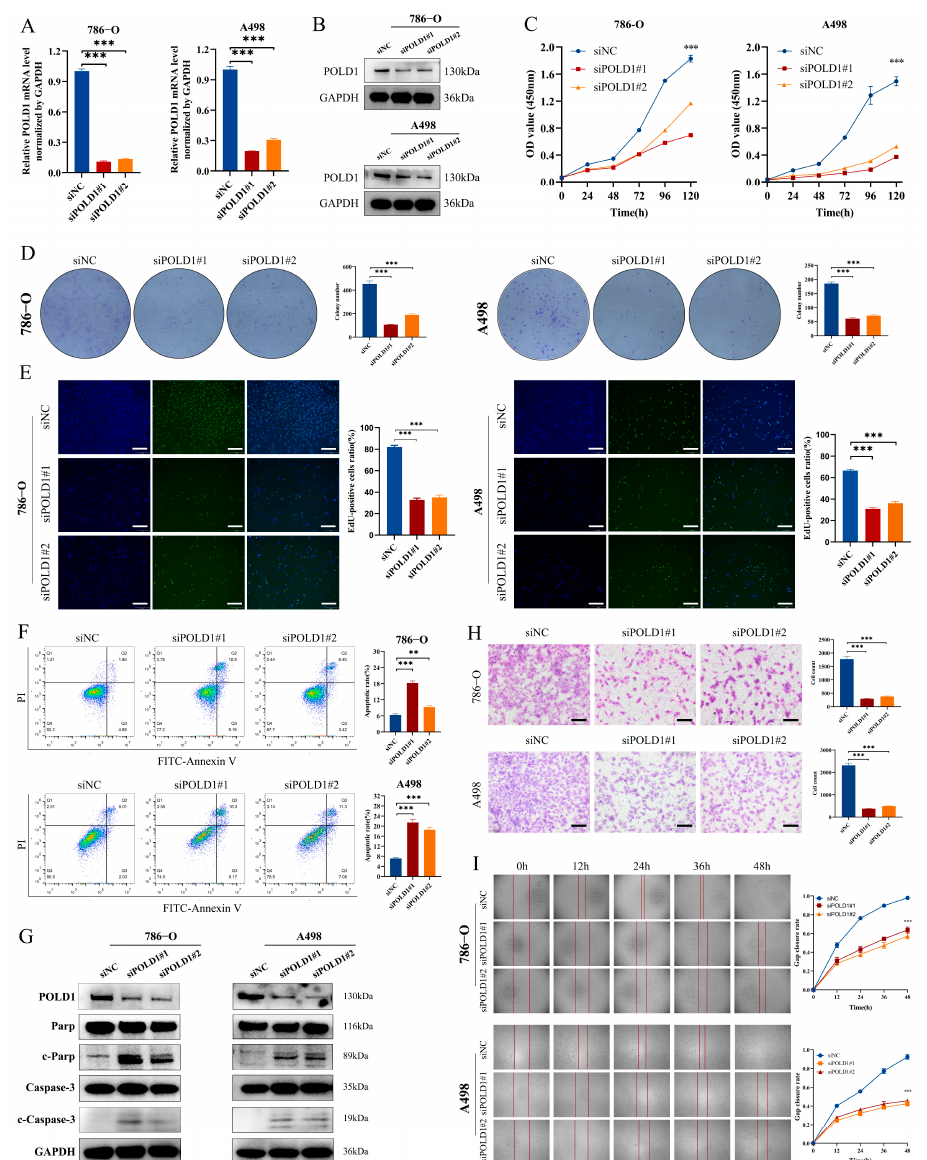
Figure 8. Knockdown of POLD1 inhibited the malignant biological behaviors of ccRCC cells in vitro. ( A , B ) The level of POLD1 was evaluated by RT-qPCR ( A ) and Western blot ( B ) after the knockdown of POLD1 in ccRCC cells. ( C – E ) The proliferation of ccRCC cells was detected by CCK-8 ( C ), colony- formation ( D ), and EdU assays ( E ). ( F , G ) Inhibition of POLD1 resulted in increased apoptosis in ccRCC cells via flow cytometry ( F ) and Western blot assay ( G ). ( H , I ) The migration of ccRCC cells was detected by Transwell assay ( H ) and wound healing assay ( I ). Differences were considered significant at p < 0.05 (** p < 0.01, *** p <